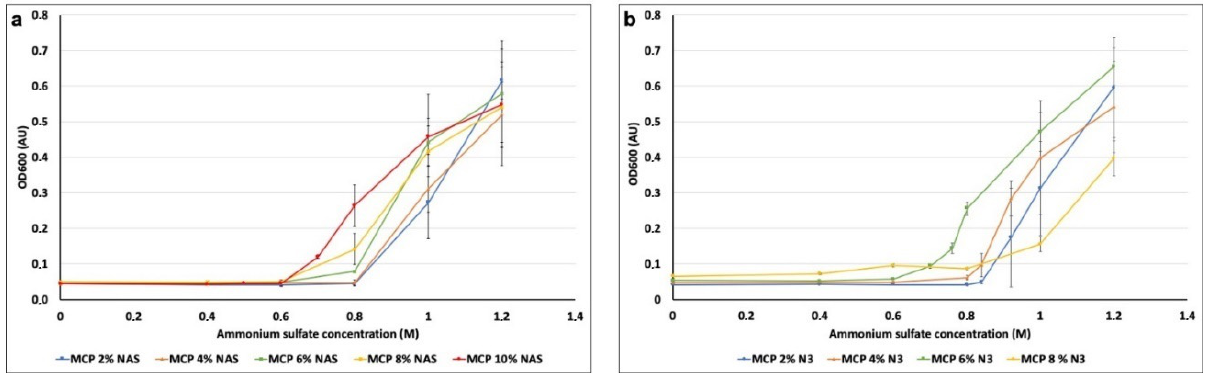
Figure 4. Variation of OD 600 measured for each MCP polymer bearing ( a ) NAS functionality and ( b ) azide groups after the addition of increasing amounts of ammonium sulfate.